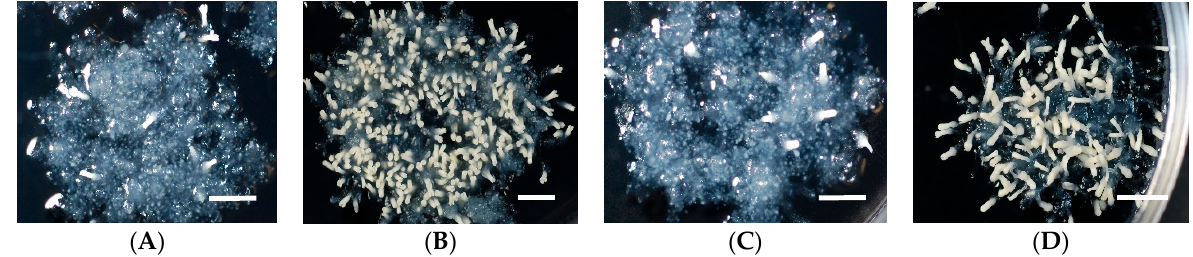
Figure 1. Somatic embryo maturation of sugi S-18 ECL on different media: ( A ) B5, ( B ) EM, ( C ) MS, and ( D ) WP media. Bars: 5 mm. Table 2. Summary of deviances of the generalized linear model (GLM) of data from Table 1 (Effect of basal salts (BS) of medium on somatic embryo maturation efficiency of sugi embryogenic cell lines (ECLs)). Deviance of the variable “null” indicates the null deviance (deviance of the null model), and other deviances indicate the residual deviance (deviance of the variable).